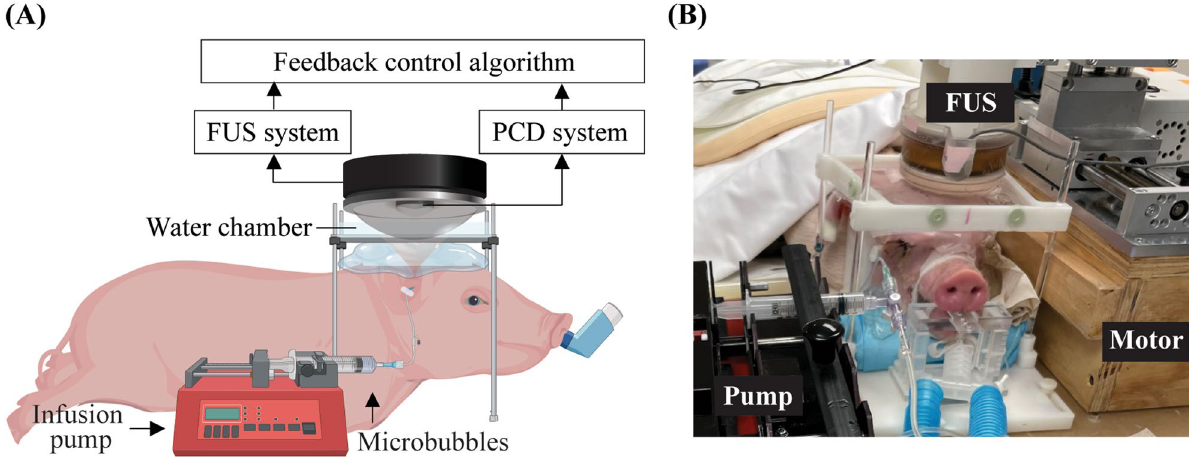
Figure 1. Experiment setup for in vivo experiment ( A ) Illustration of the feedback-controlled FUS system. The experiment setup was composed of three parts: (1) FUS system: FUS transducer, function generator, and power amplifier. (2) PCD system: PCD, pre-amplifier, and PicoScope. (3) Feedback control algorithm: a customized MATLAB program for the feedback control. ( B ) Picture of the experiment setup during the pig study. The FUS transducer was connected to a 3D stage for